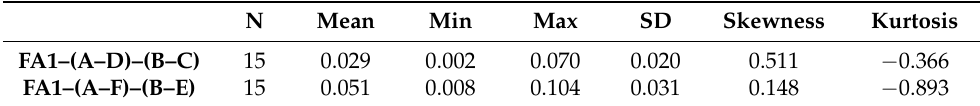
Table 5. Basic statistics of the asymmetry index of bilateral measurements of the maxillary alveolar process—test group.